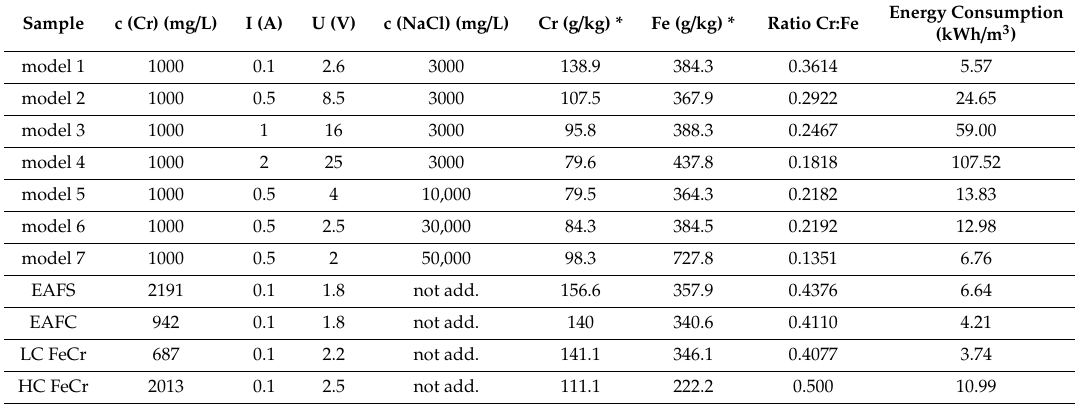
Table 2. Amount of Cr and Fe in the EC solid product and energy consumption for di ff erent current intensities and NaCl concentrations at pH =